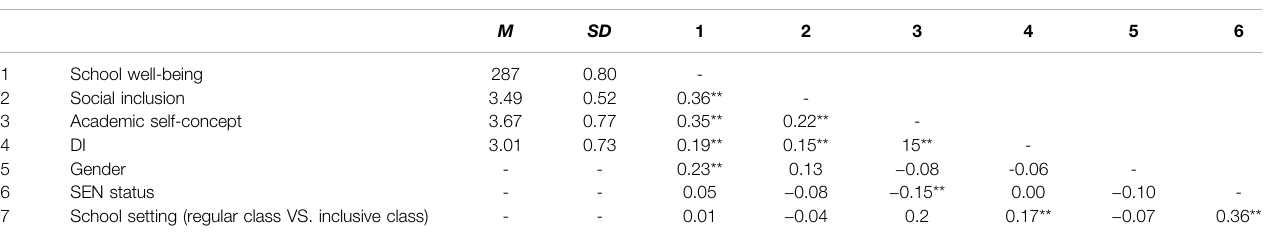
TABLE 3 | Means, standard deviations, and correlations of all